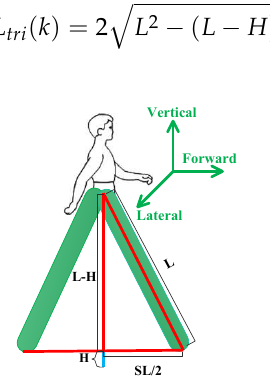
Figure 2. Step length